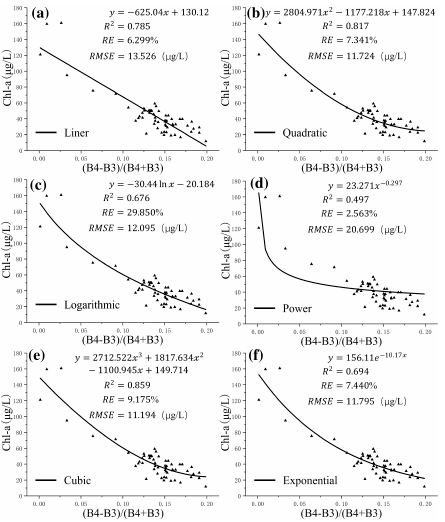
Figure 3. Comparison between in situ Chl-a and (B4 − B3)/(B4 + B3) using different algorithms, including ( a ) linear; ( b ) quadratic; ( c ) logarithmic; ( d ) power; ( e ) cubic and ( f ) exponential.